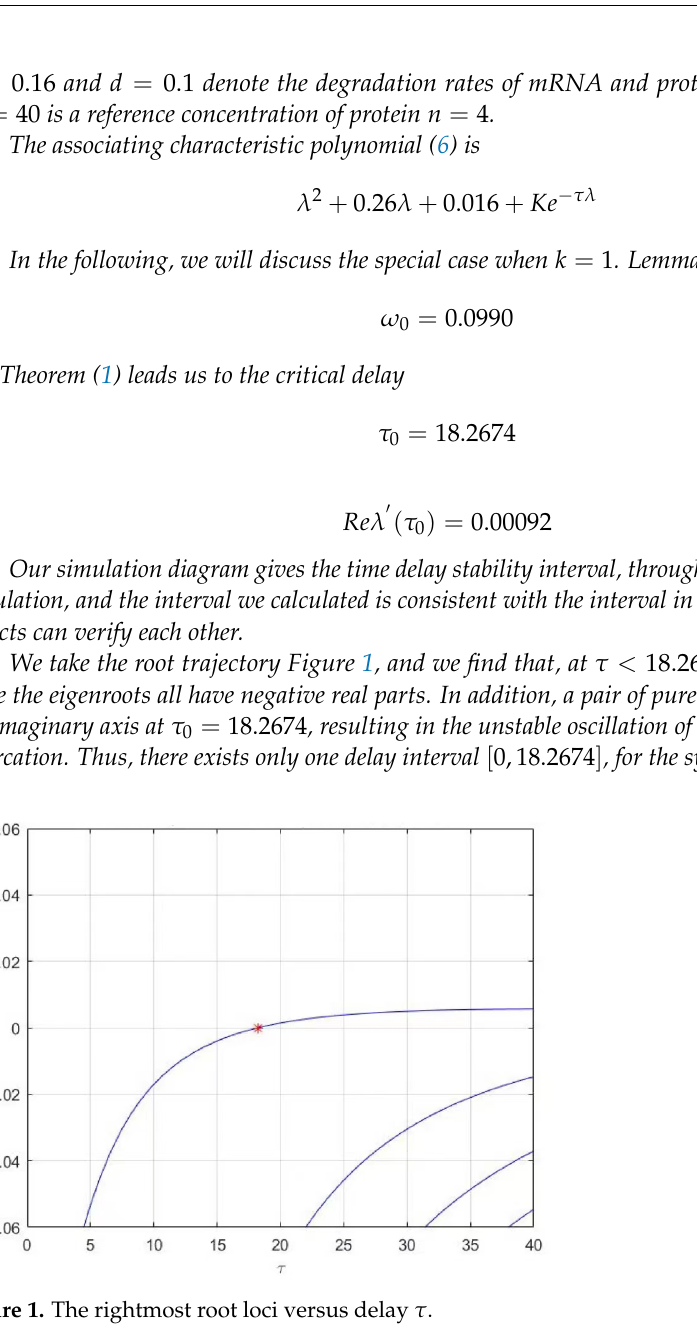
Figure 1. The rightmost root loci versus delay τ